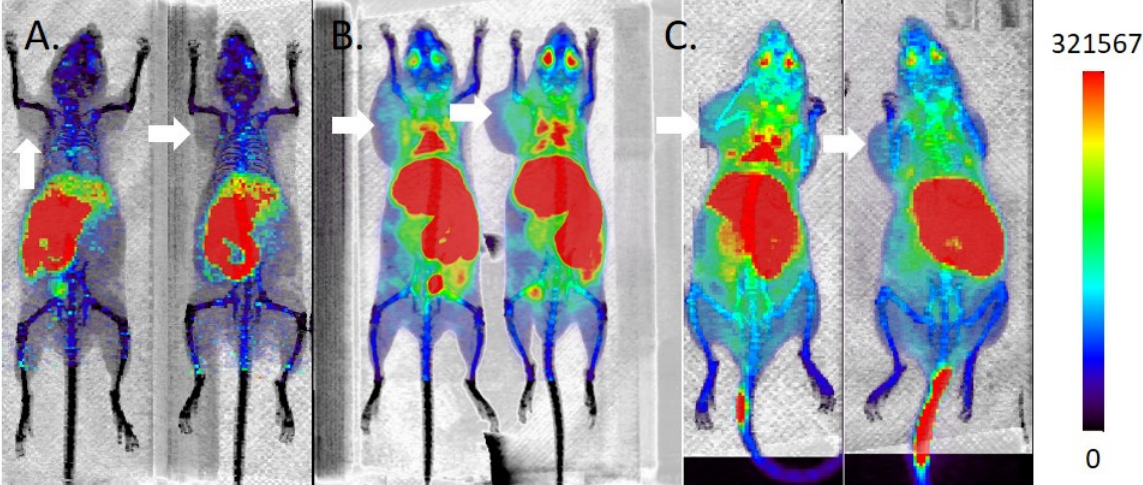
Figure 7. Maximum intensity projection microPET/CT images of 11 C-labeled triazolones in male inbred athymic nu/nu mice bearing LNCaP xenografts ( n > 4 per compound). Mice were imaged in groups of 4, with 2 representative examples shown per compound. Tumors are indicated with white arrows. The mice were administered ( A ) 8–10 MBq [ 11 C] 4 in 10% EtOH/saline; ( B ) 9–11 MBq [ 11 C] 5 in 10% EtOH/saline; ( C ) 9–11 MBq [ 11 C] 6 in 10% EtOH/saline.